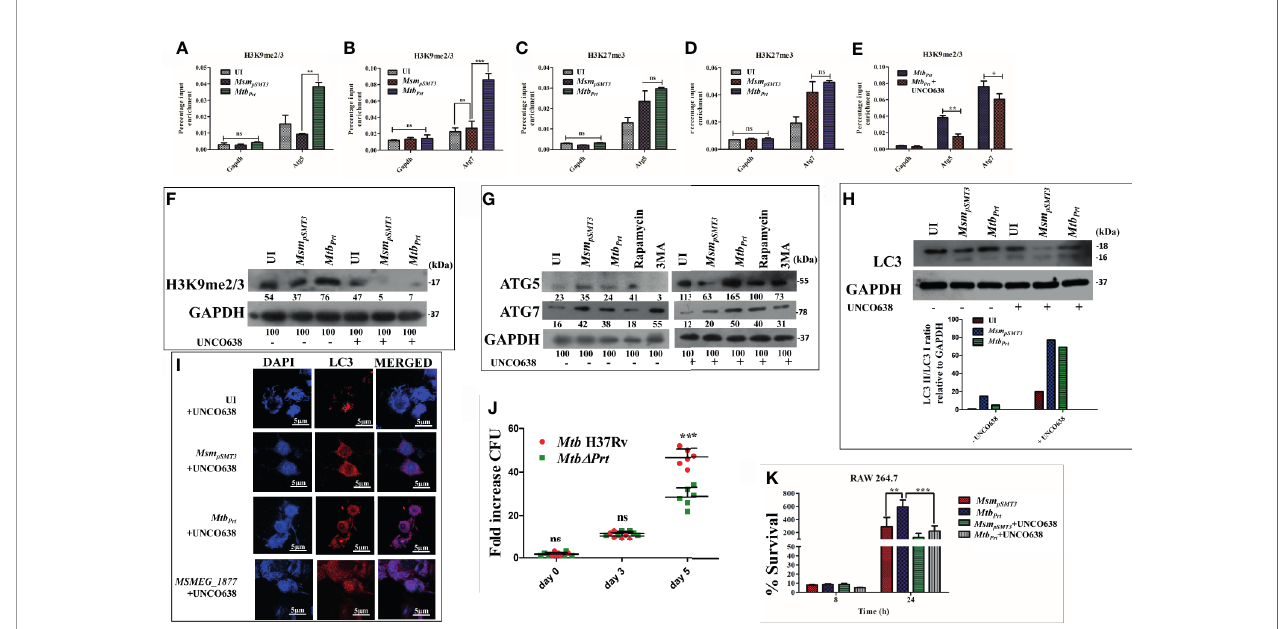
FIGURE 3 | Role of H3K9 and H3K27 hypermethylation in inhibition of autophagy by Mtb Prt .. ChIP assay was performed to check the H3K9me2/3 enrichment at (A) Atg5 and (B) Atg7 promoter after infecting RAW264.7 with Msm pSMT3 and Mtb Prt . To check the H3K27me3 enrichment at (C) Atg5 and (D) Atg7 , ChIP assay was performed after infecting RAW macrophages with Msm pSMT3 and Mtb Prt . (E) ChIP assay was performed to check the H3K9me2/3 enrichment after treatment with G9a inhibitor. Quanti fi cation of the data was done by qRT-PCR using gene speci fi c ChIP primers. RAW264.7 cells were infected with Msm pSMT3 and Mtb Prt followed by treatment with UNC0638 (G9a inhibitor) for 24 h. Expressions of (F) H3K9me2/3, (G) ATG5 and ATG7, and (H) LC3-I to II conversion were checked by western blotting after 24 h of infection (Densitometry is representative to the particular western blot data). (I) LC3 puncta formation was con fi rmed by performing confocal microscopy in cells infected with Msm pSMT3 , Mtb Prt and MSMEG_1877 followed by treatment with UNCO638 treatment for 24 h. (J) RAW264.7 were infected with Mtb H37Rv and Mtb D Prt strains. Cells were lysed and intracellular survival was determined 0, 3- and 5-days post-infection by a CFU assay. (K) RAW 264.7 were infected with Msm pSMT3 and Mtb Prt strains followed by UNCO638 treatment. Cells were lysed and intracellular bacterial survival was determined 8 and 24 h post-infection by a CFU assay. Experiments were performed in triplicate (n = 3). Results are shown as mean ± S.D. ***p ≤ 0.001; **p ≤ 0.01; *p ≤ 0.05.; ns,